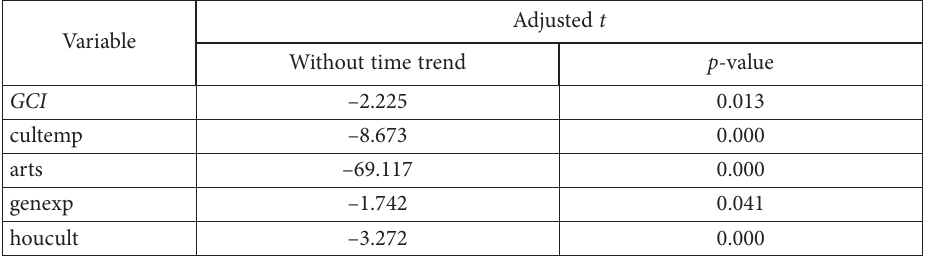
Table 6. Levin-Lin-Chu panel unit root test for model 2018–2020 (source: compiled by the author) Variable